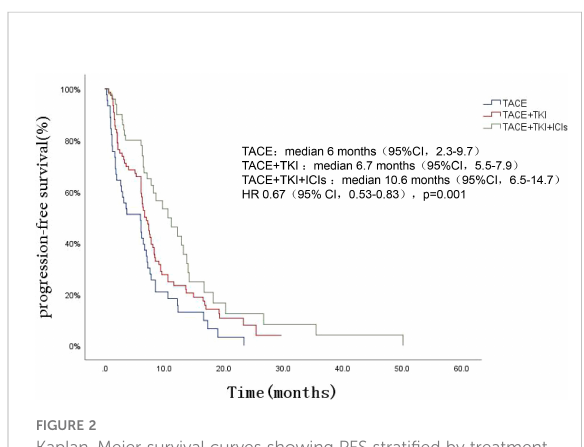
FIGURE 2 Kaplan-Meier survival curves showing PFS strati fi ed by treatment options in patients of